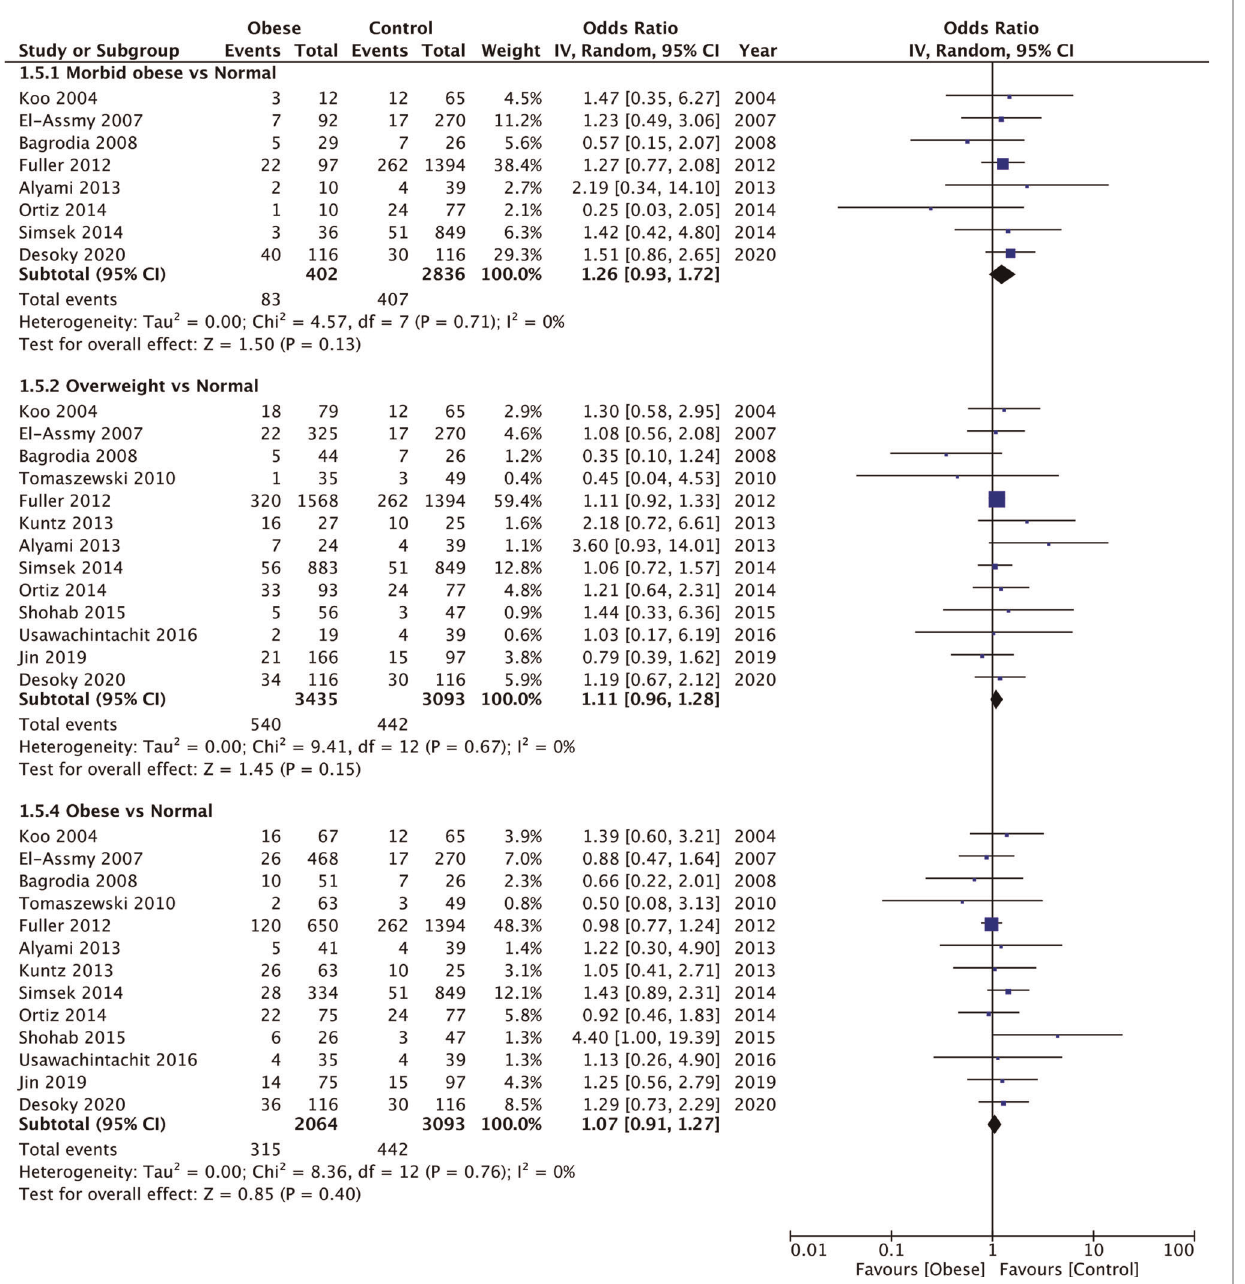
FIGURE 6 | Meta-analysis of complication rates between morbid obese, overweight and obese vs normal BMI